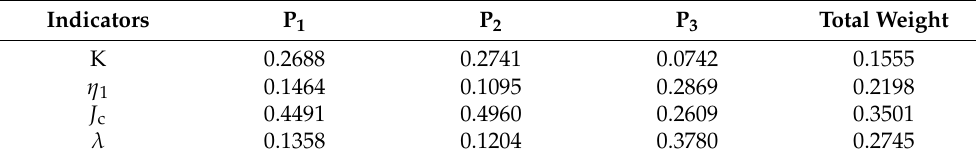
Table 7. Total AHP